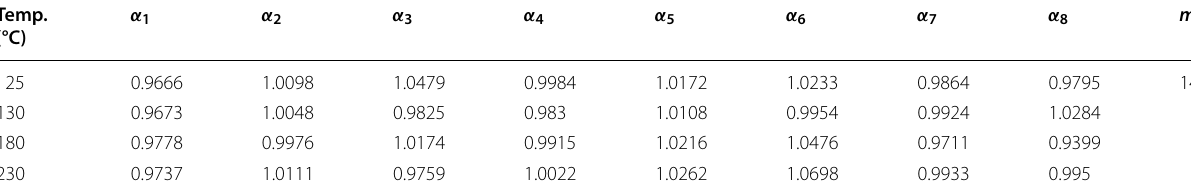
Table 6 Identified parameters of Yld2000-2d yield function with m = 14 ( ε p = 0.002 ) Temp. (°C)